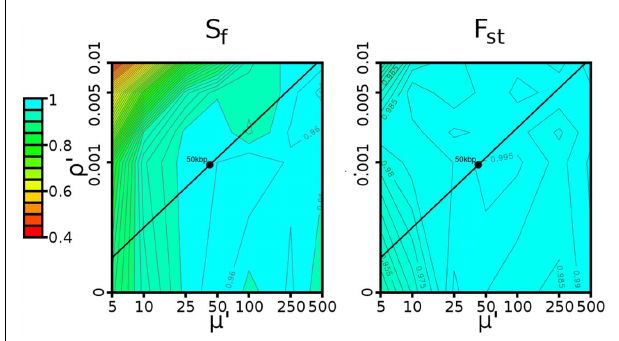
FIGURE 4 | Contour plot describing determination of window size. The power of the (left) S f and (right) F st statistics for various combinations of recombination rate ( ρ (cid:8) = ρ · w ) and mutation rate ( μ (cid:8) = μ · w ). In both cases, the selection pressure was 0.08 (strong), and thresholds were defined by a 1% false positive rate, as described in Section 2.5.The black line represents the range of possible values caused by varying the window size in Drosophila .The black circle represents the 50-kbp window size ultimately chosen, which shows high ( ≥ 95%) power for both S f and F st